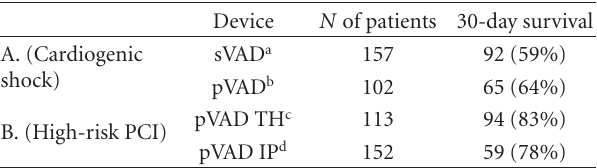
TH means TandemHeart, IP is for Impella Recover 2.5LP; (a) pooled data from 11 trials [17, 28–37], (b) pooled data from 11 trials [5–7, 15, 19, 38– 43], (c) pooled data from 11 trials [44–54], and (d) pooled data from 10 trials